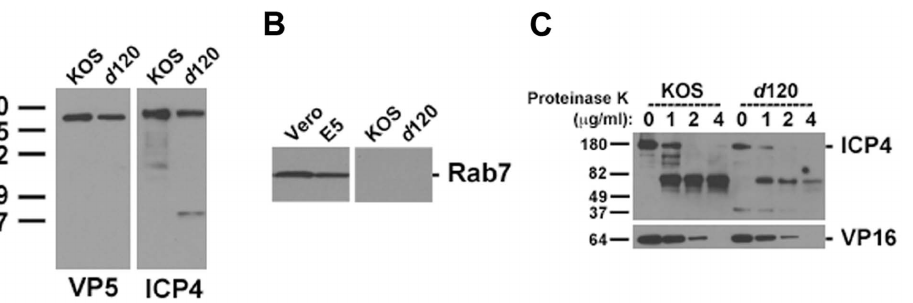
Figure 1. Detection and localization of ICP4 in HSV-1 d 120 virions propagated on ICP4 complementing cell line E5. Approximately similar amounts of cell-free supernatant preparations, as estimated by densitometry of VP5, of HSV-1 KOS or d 120 or cell lysates of uninfected Vero or E5 cells were separated by 4–20% SDS-PAGE. Western blots were probed with MAbs to HSV VP5 or HSV ICP4 (A), or cellular Rab7 (B). Results shown are representative of three (A) or two (B) independent experiments. (C) Extracellular HSV-1 KOS or d 120 virions were treated with the indicated concentrations of Proteinase K for 15 min on ice. Samples were immediately boiled in Laemmli buffer and separated by 4–20% SDS-PAGE. Western blots were probed with MAbs to ICP4 or VP16. Results shown are representative of at least five independent experiments. Molecular weight standards in kiloDaltons are indicated to the left of each panel.